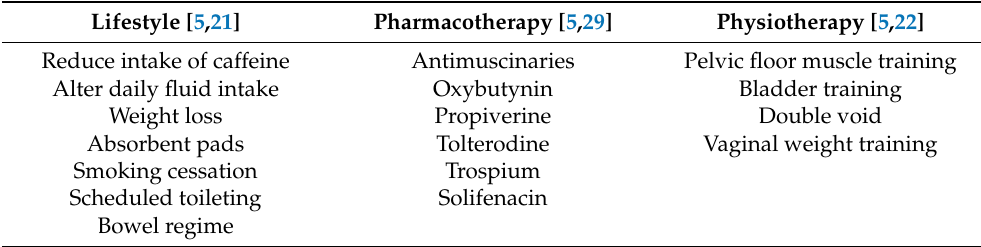
Table 3. Conservative management strategies for OAB.